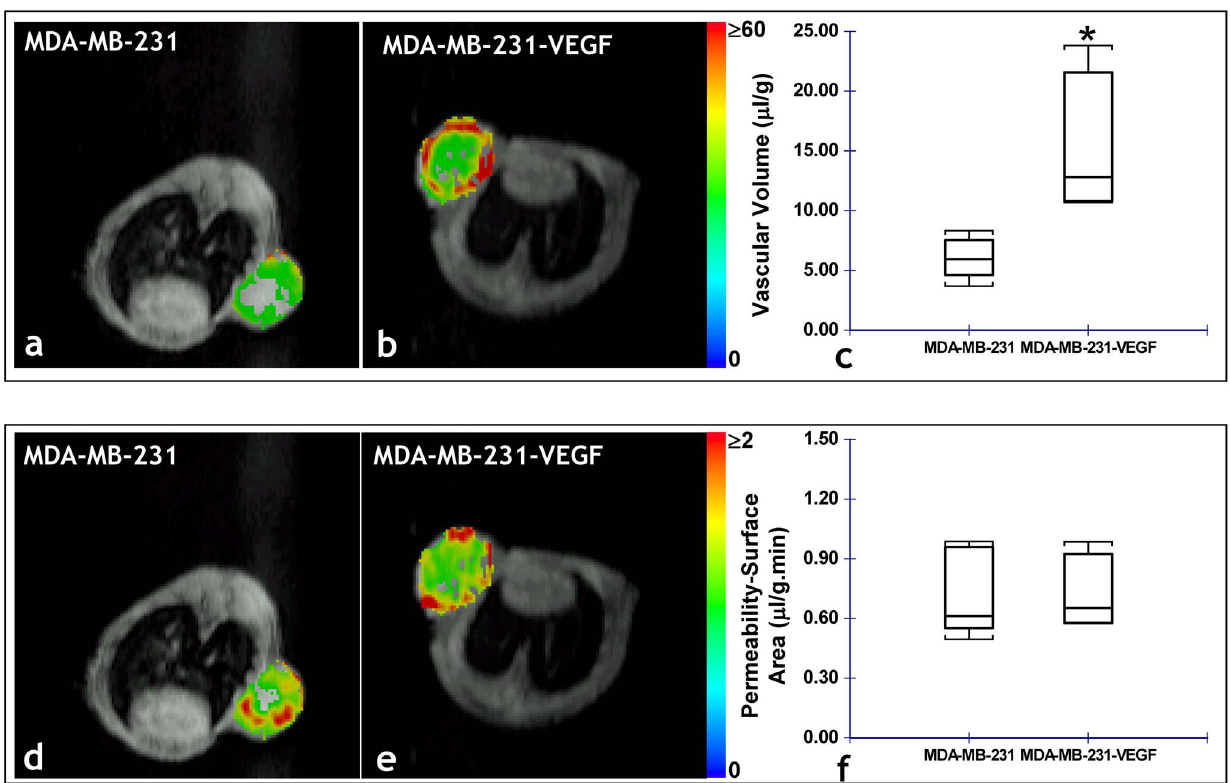
Figure 4. Invivo MRI reveals VEGF overexpression alters the angiogenic phenotype of MDA-MB-231 tumors. Representative functional MRI maps of the vascular volume from: (a) MDA-MB-231 and (b) MDA-MB-231 VEGF overexpressing tumor bearing animals. (c) Box-and-whisker plot comparing the vascular volume between MDA-MB-231 (n=5) and MDA-MB-231-VEGF (n=4) xenografts (*p=0.0159 with the two-tailed Mann- Whitney U Test). Representative functional MRI maps of the permeability-surface area product from: (d) MDA-MB-231 and (e) MDA-MB-231 VEGF overexpressing tumor-bearing animals. (f) Box-and-whisker plot comparing the permeability-surface area product between MDA-MB-231 (n=5) and MDA-MB-231-VEGF (n=4) xenografts.